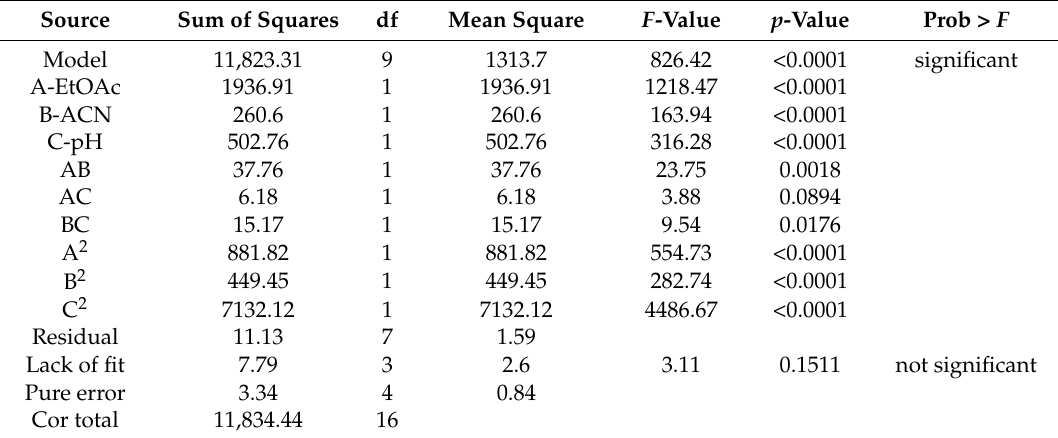
Table 2. ANOVA for dependent variable: the recovery of